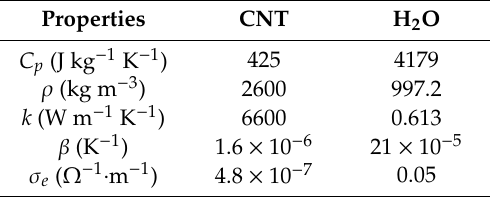
Table 1. Properties of CNT (Carbon Nanotube) and water